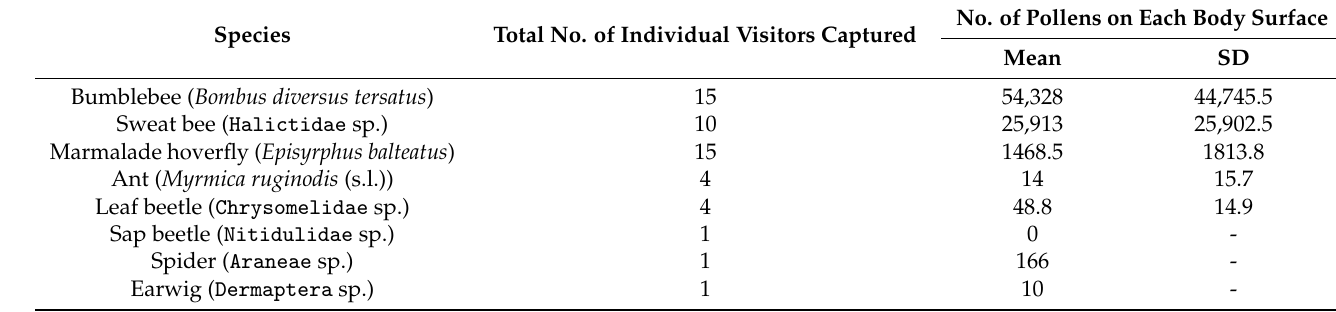
Table 3. The total number of pollen grains attached on the surface of the flower-visiting animals.